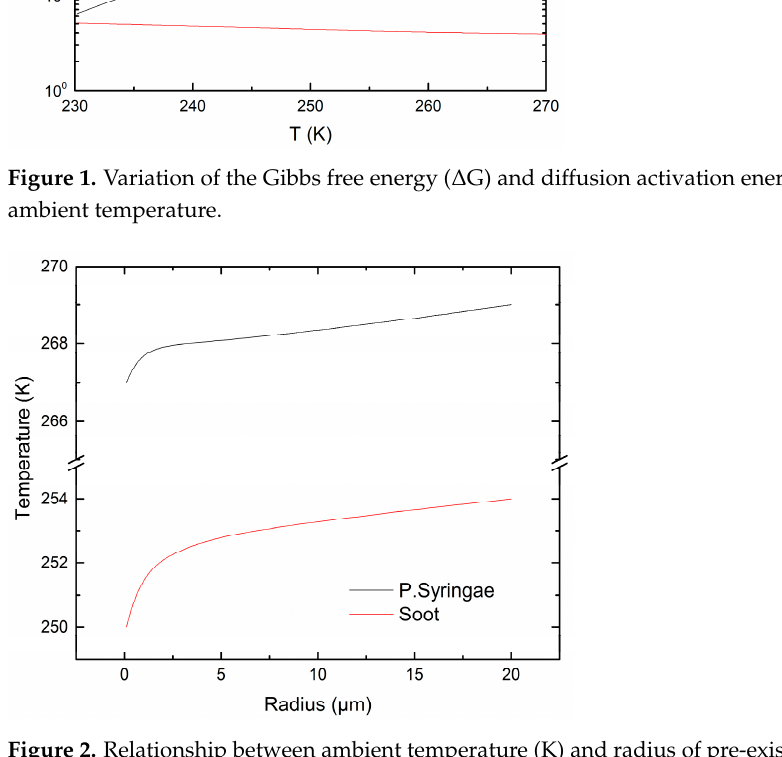
Figure 2. Relationship between ambient temperature (K) and radius of pre-existing particles ( μ m) at IN activation conditions.